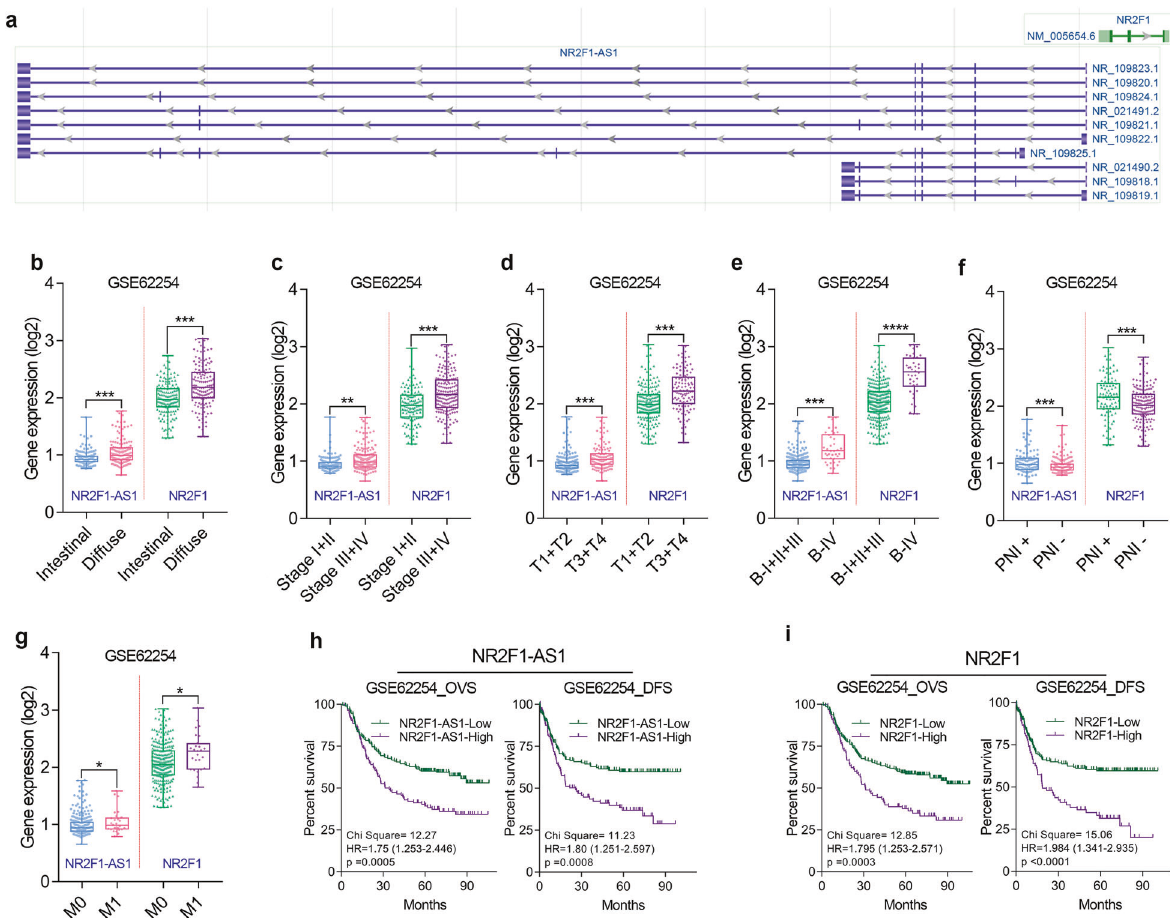
Fig. 1 The clinical signi fi cance of NR2F1-AS1 and NR2F1 was analyzed in the GSE62254 cohort. a Antisense lncRNA NR2F1 has multiple types of transcripts according to the annotation of NCBI. b Difference in expression levels of NR2F1-AS1 and NR2F1 between intestinal and diffuse GC tissues. c – e NR2F1 and NR2F1-AS1 expression level in different Pathologic stages, T-stages and Borrmann-stages of GC. f NR2F1 and NR2F1-AS1 expression level in GC tissues with/without perineural invasion. g NR2F1 and NR2F1-AS1 expression level in GC tissues with different M-stages. h , i Overexpression of NR2F1 and NR2F1-AS1 predicted poor prognosis in GSE62254 cohort. **** P < 0.0001; *** P < 0.001; ** P < 0.01; * P <